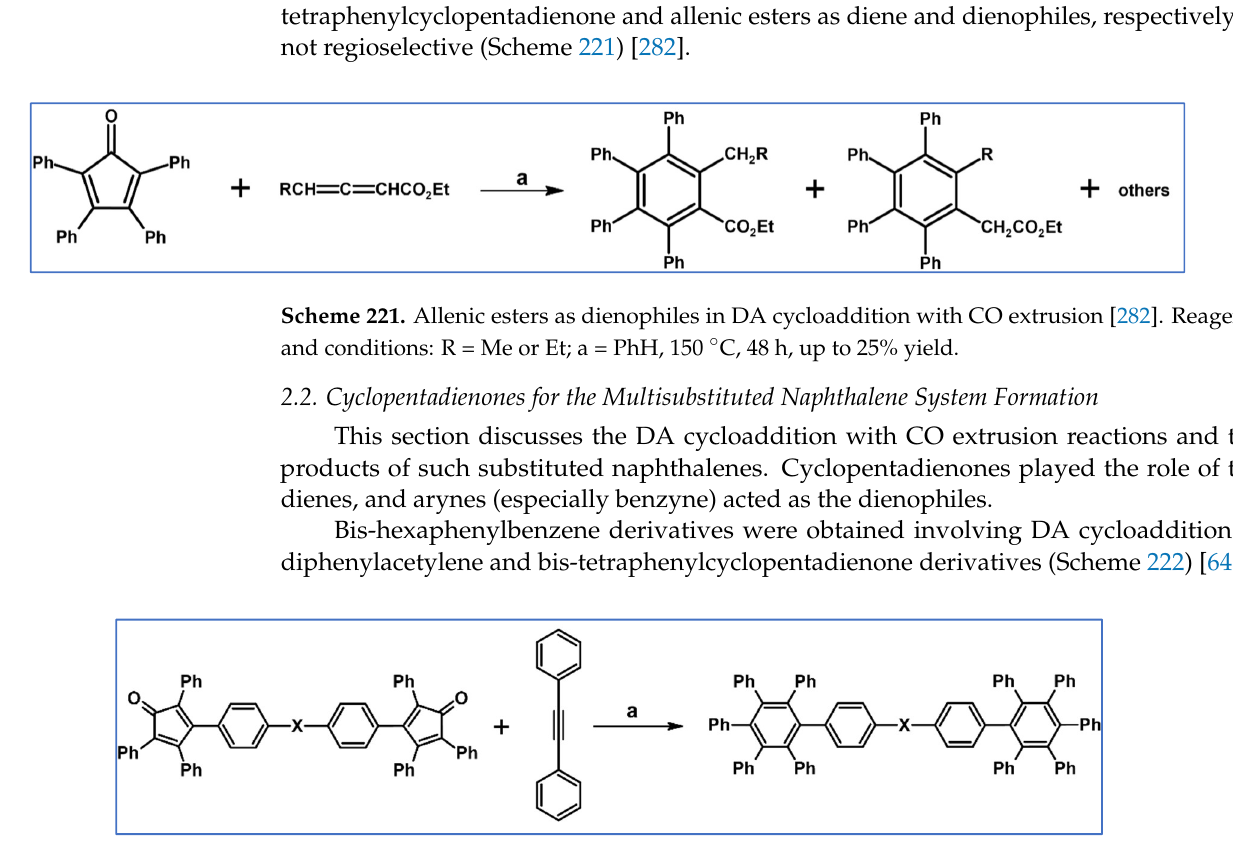
Figure 1. Patented polyarylbenzenes obtained via DA cycloaddition with CO extrusion